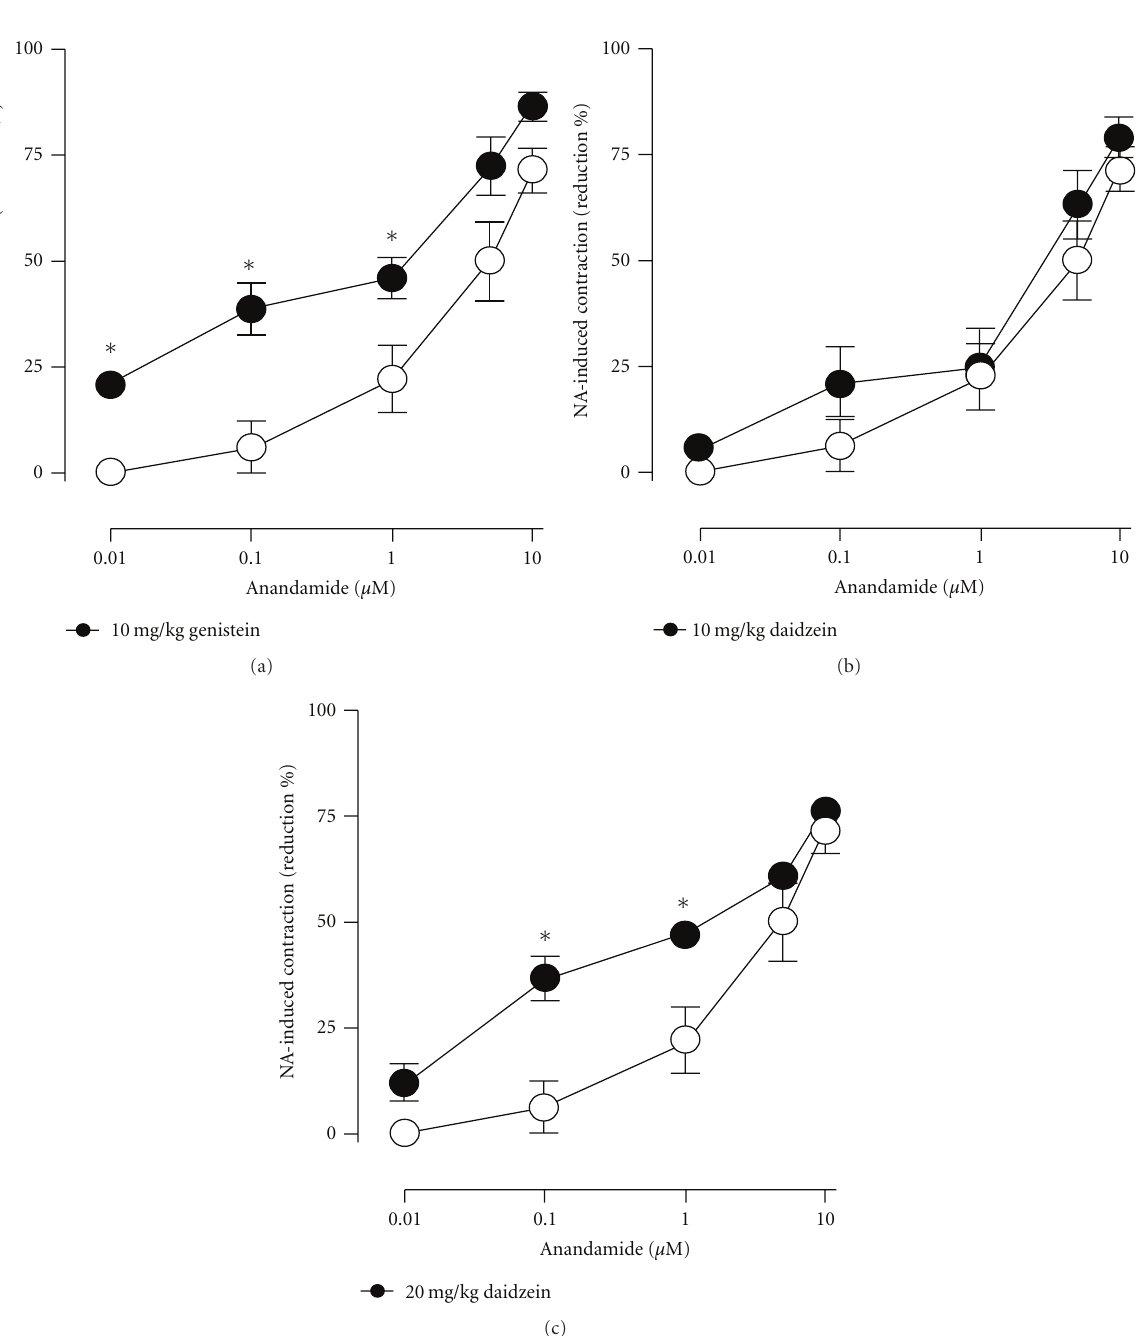
Figure 3: E ff ects of 3-day administration of 10 mg/kg genistein in (a), 10mg/kg daidzein in (b), and 20mg/kg daidzein in (c) on the anandamide-induced reductions of contractile responses to NA in mesenteric beds isolated from ovariectomized female rats. Vehicles are depicted in open circles. ∗ P < 0 . 05 when treatments were compared to the corresponding